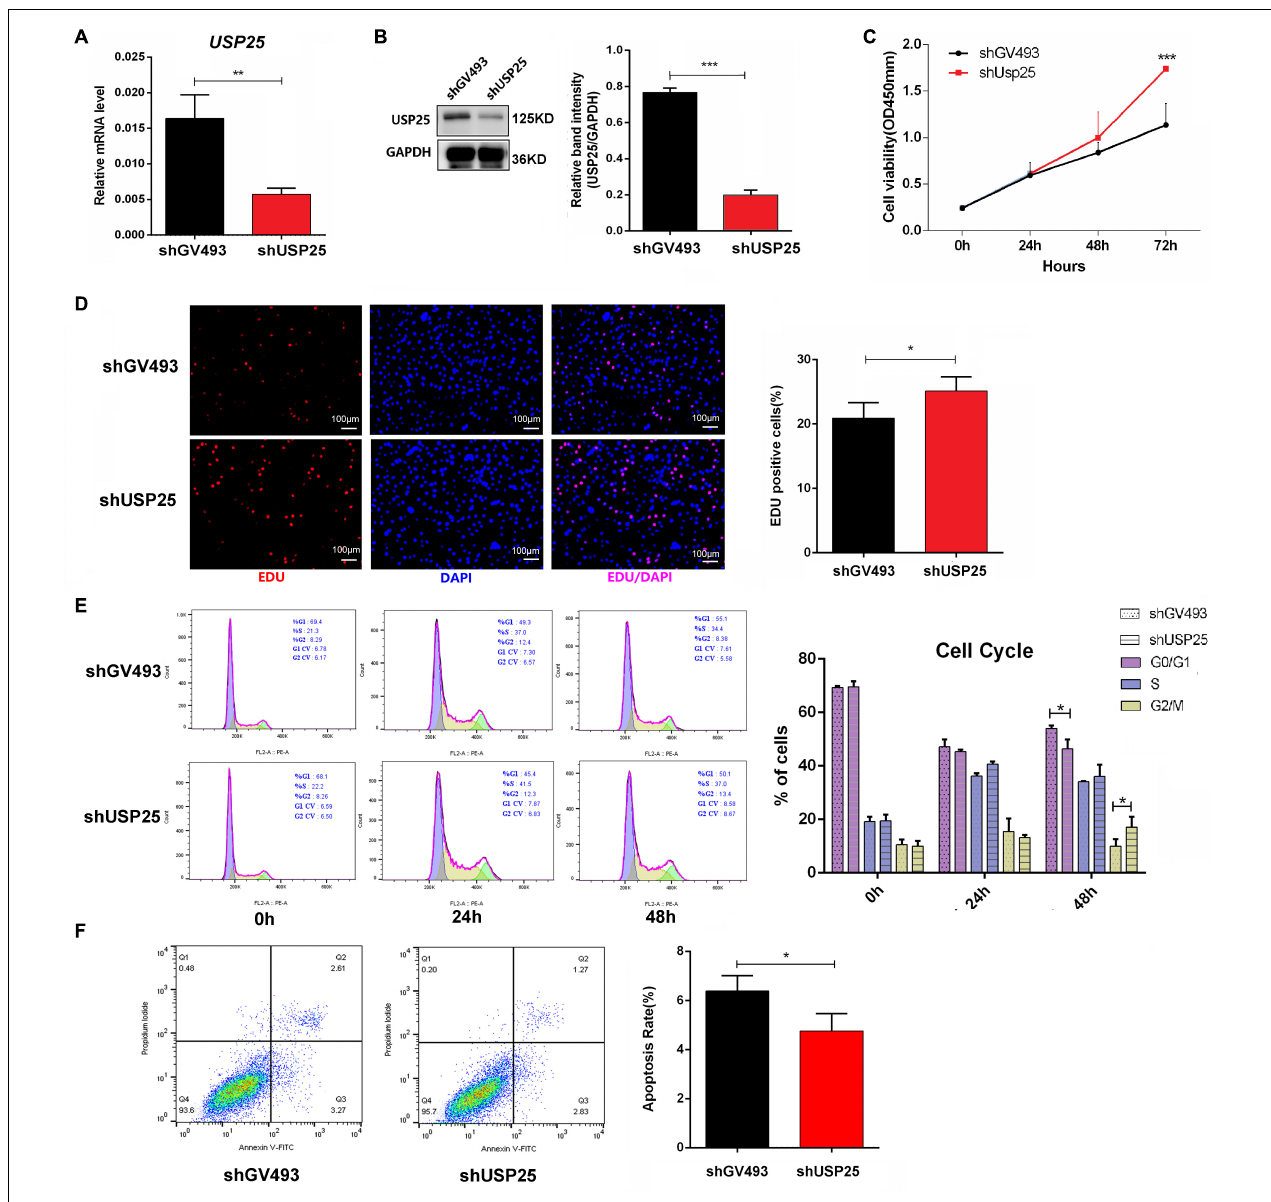
FIGURE 3 | Loss of USP25 improved the proliferation and inhibited the apoptosis of human ovarian GCs. (A) The expression of USP25 was detected by real-time PCR after KGN cells were infected with shUSP25 or shGV493 lentivirus. ** P < 0.01. (B) The expression of USP25 at the protein level was revealed by Western blots in the shGV493 and shUSP25 cells. The quantification of protein levels is presented on the right. Values were normalized to the GAPDH expression level and are indicated as the mean ± SD. n = 3. *** P < 0.001. (C) Cell Counting Kit-8 assay of KGN cells in the shGV493- and shUAP25-treated cells. *** P < 0.001. (D) Representative images and the quantification of EdU (+) in KGN cells. Scale bar = 100 µ m. * P < 0.05. (E) Effects of USP25 knockdown on KGN cell cycle distribution determined using flow cytometry. * P < 0.05 for each group. (F) Apoptosis of KGN cells in each group was detected by flow cytometry. A cartogram of apoptosis of KGN cells is shown on the right. * P < 0.05. Data are expressed as the mean ± SD. The P -values were calculated by an unpaired two-tailed Student’s t